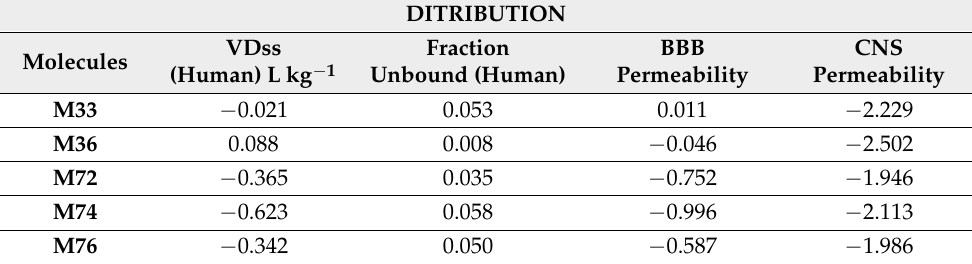
Table 4. Distribution profile of the proposed pyrazole derivatives.